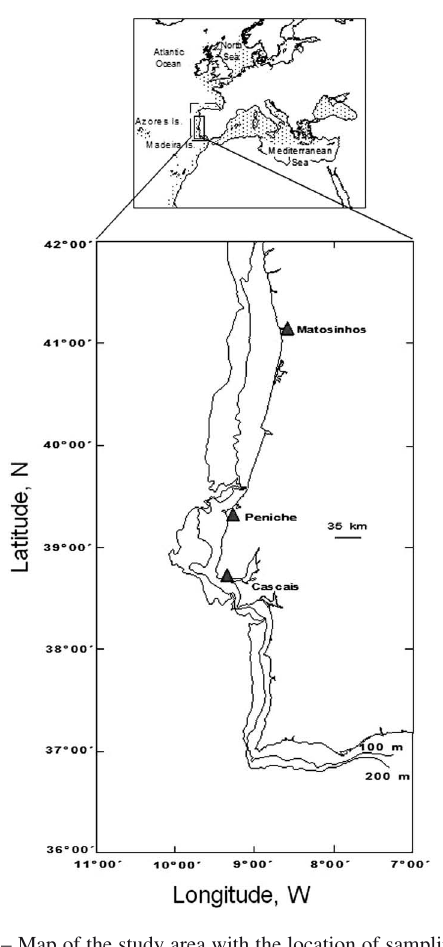
Fig . 2. – Map of the study area with the location of sampling ports (triangles). The map on the top shows the area of distribution of the species and the delimitation of the Atlanto-Iberian sardine stock (dashed